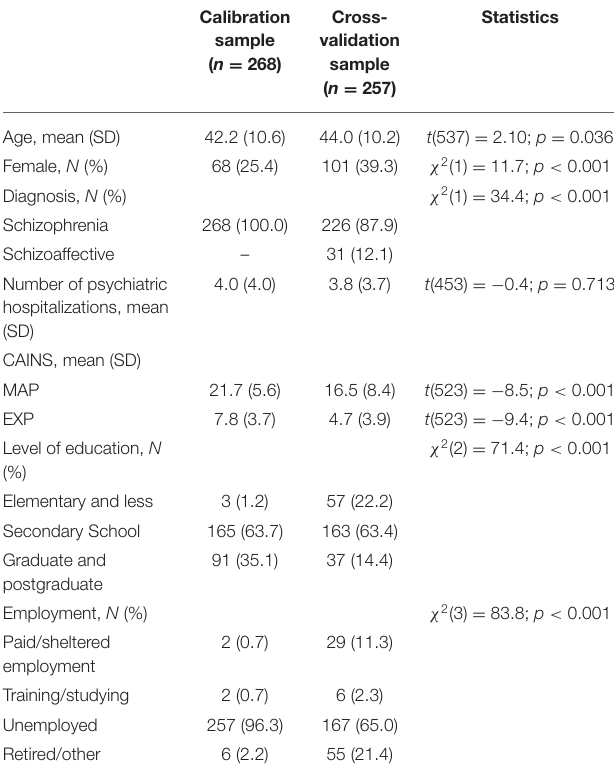
TABLE 1 | Description and comparison between the calibration and cross-validation